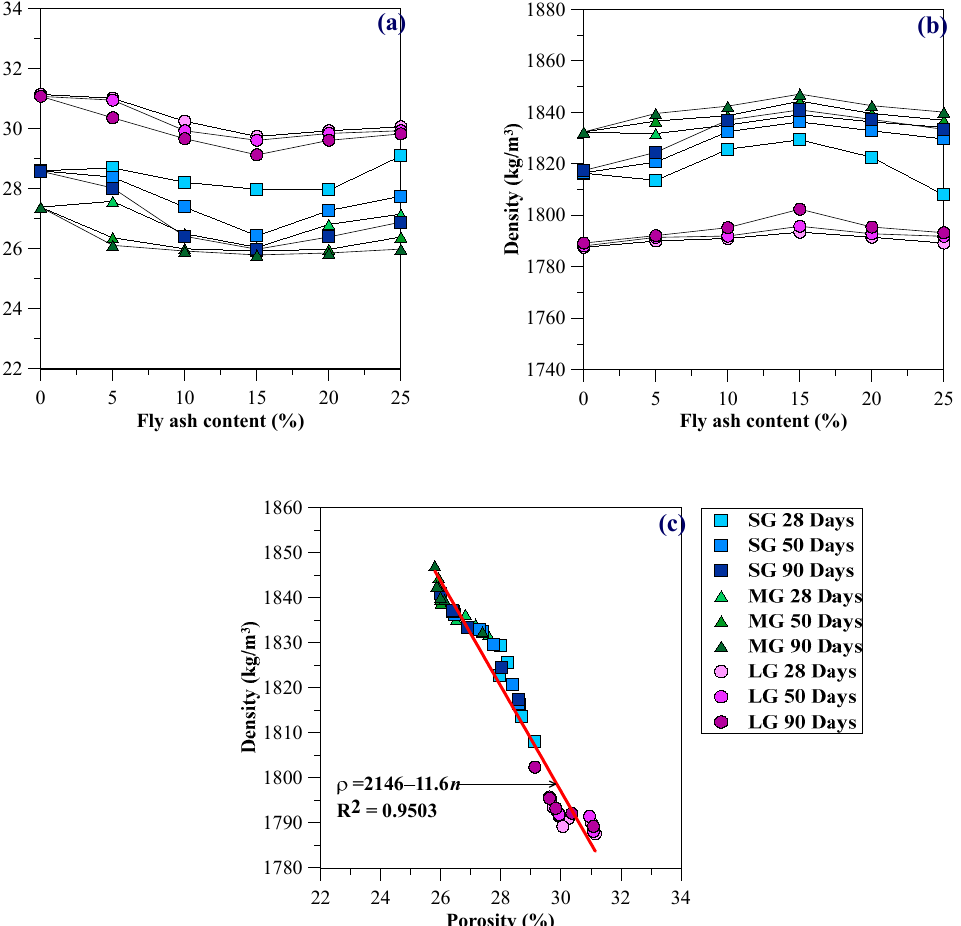
Figure 9. Relationships between ( a ) porosity and fly ash content, ( b ) density and fly ash content, and ( c ) density and porosity.